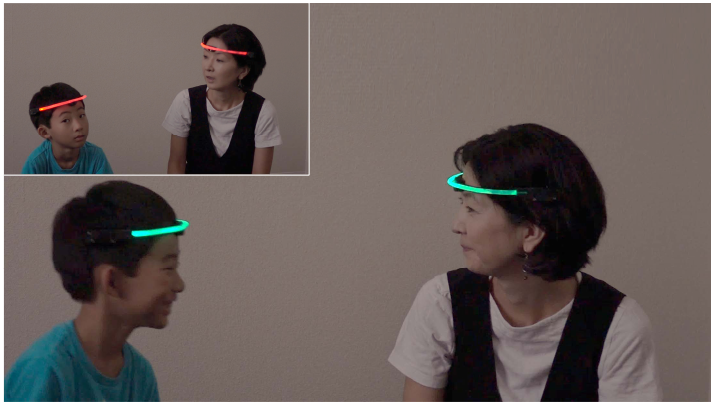
Figure 1. FaceLooks : wearable devices measuring and visually representing face-to-face behavior in real